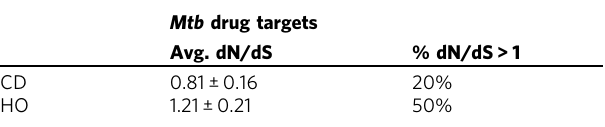
The mutation rates of core gene drug targets in multi, extensively, or totally drug-resistant Mtb strains were analyzed by gene orientation. Genes under overt positive selection are indicated as the fraction of genes with a dN/dS value >1. Drug targets were previously compiled by Hameed et al. 57 . Among these, we analyzed the 5 head-on and 10 co-directional core genes. Signi fi cance was determined by Student ’ s t test. p = 0.2 for HO vs. CD average dN/dS values